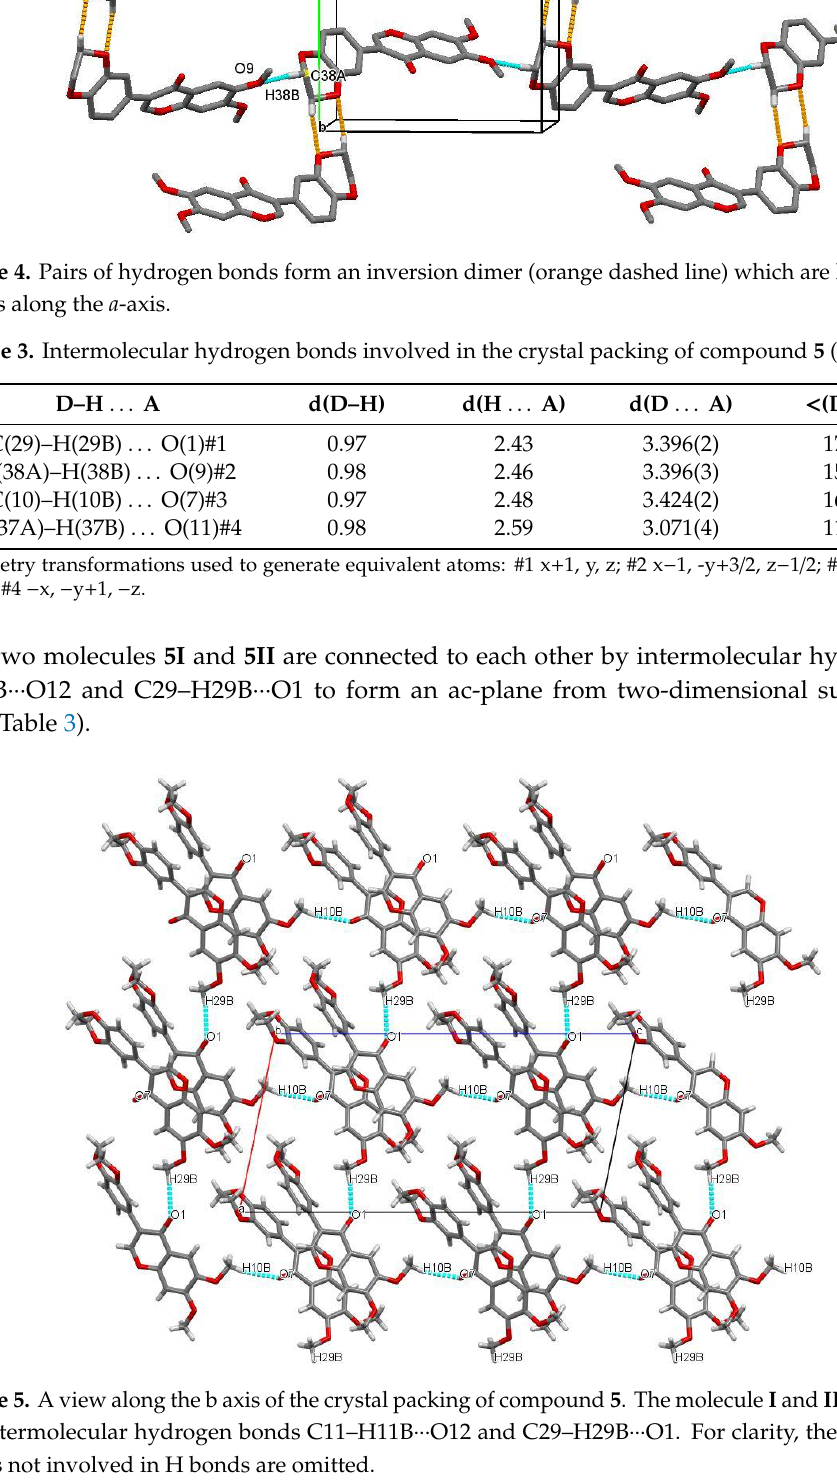
Figure 5. A view along the b axis of the crystal packing of compound 5 . The molecule I and II are linked via intermolecular hydrogen bonds C11–H11B ··· O12 and C29–H29B ··· O1. For clarity, the hydrogen atoms not involved in H bonds are omitted. Table 3. Intermolecular hydrogen bonds involved in the crystal packing of compound 5 (Å and °).